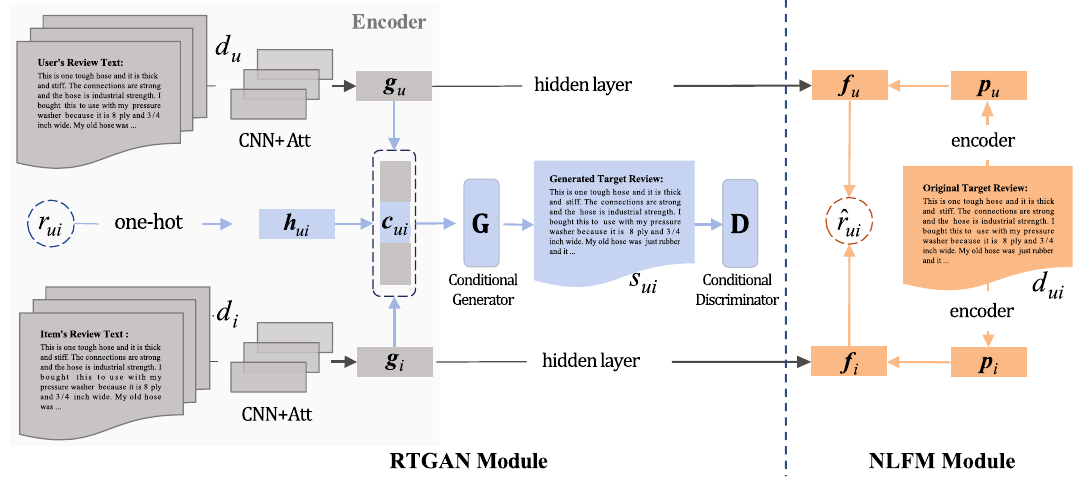
Fig. 1 The architecture of our AGTR